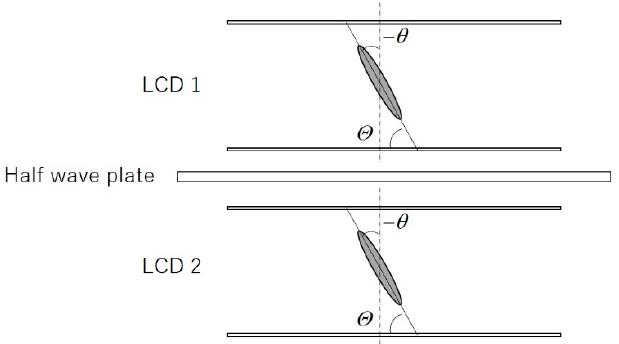
Figure 4. Structure of two-layer optically anisotropic LC filters.